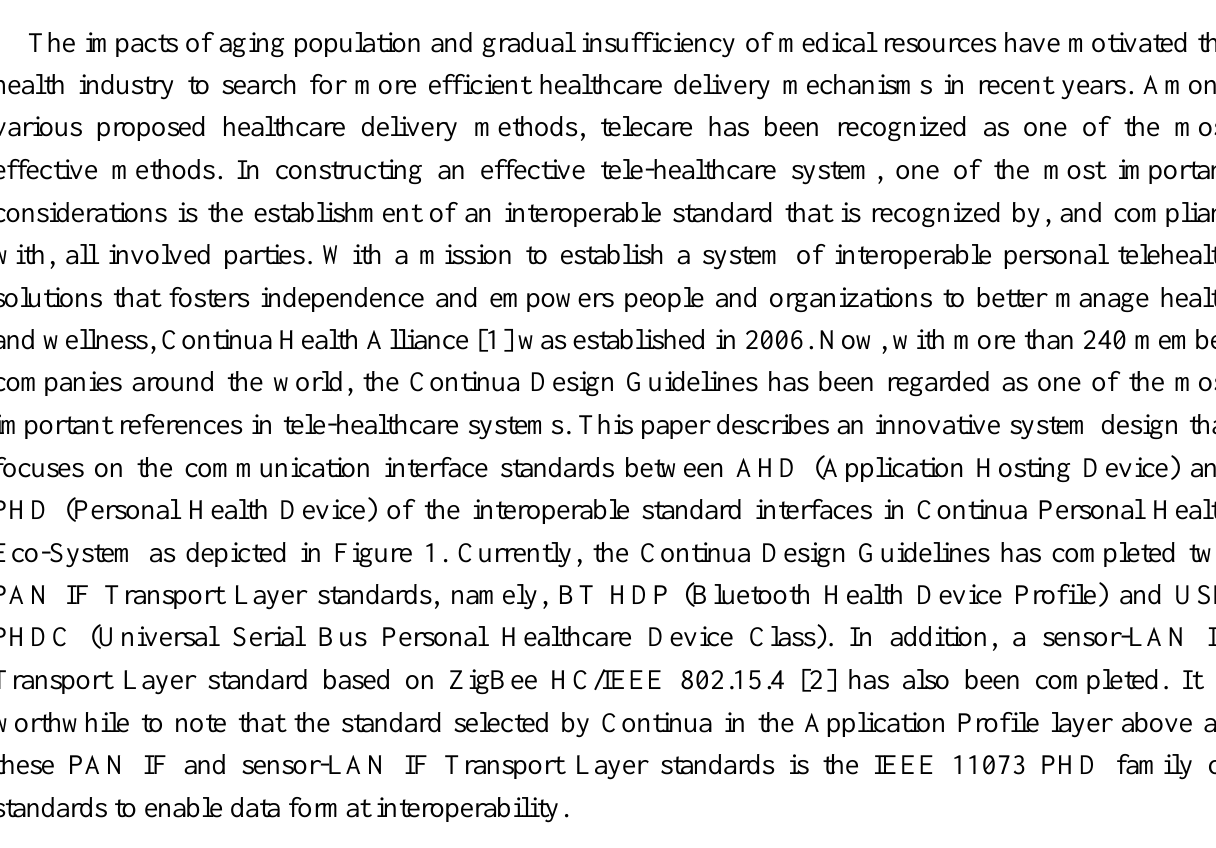
Figure 1. Interoperable standard interfaces in the Continua Personal Health Eco-System (Resource: Continua Health